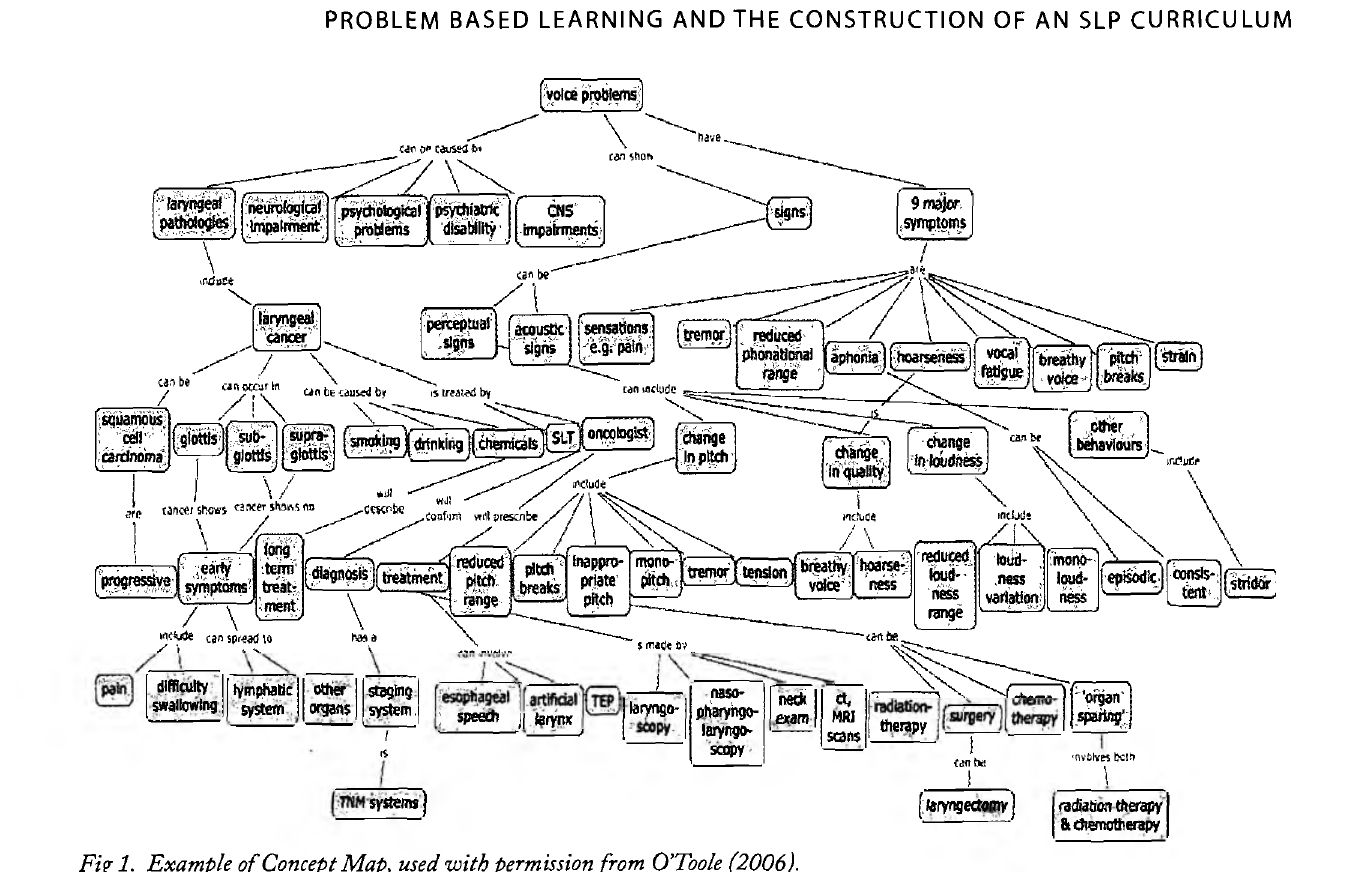
facilitation of PBL